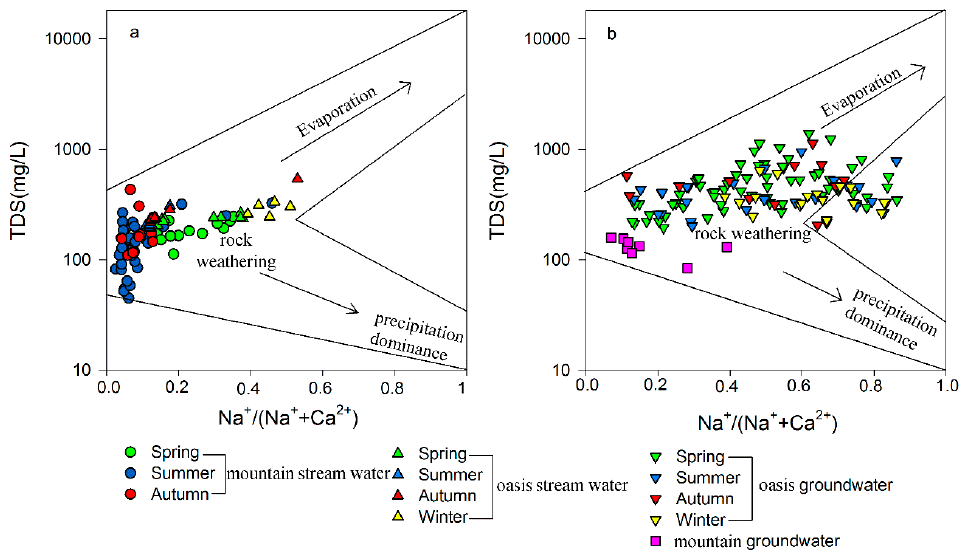
Figure 5. Gibbs diagram of ( a ) stream water and ( b ) groundwater.